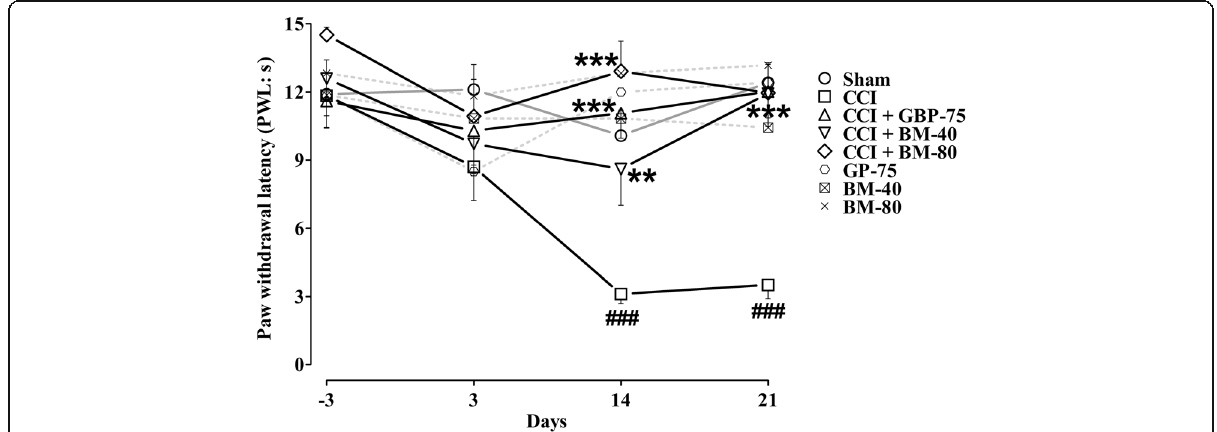
Fig. 3 Effect of Bacopa monnieri methanolic extract (BM-40 and BM-80) and gabapentin (GBP-75) on the maintenance of chronic constriction injury (CCI) induced dynamic allodynia (diminished paw withdrawal latency to light brushing; PWL in s). Values expressed as mean ± S.E.M. ### P < 0.001 compared to sham-operated animals, ** P < 0.01, *** P < 0.001 compared to CCI-operated untreated animals, two-way repeated measures ANOVA followed by post hoc Bonferroni analysis. n = 6 rats per group